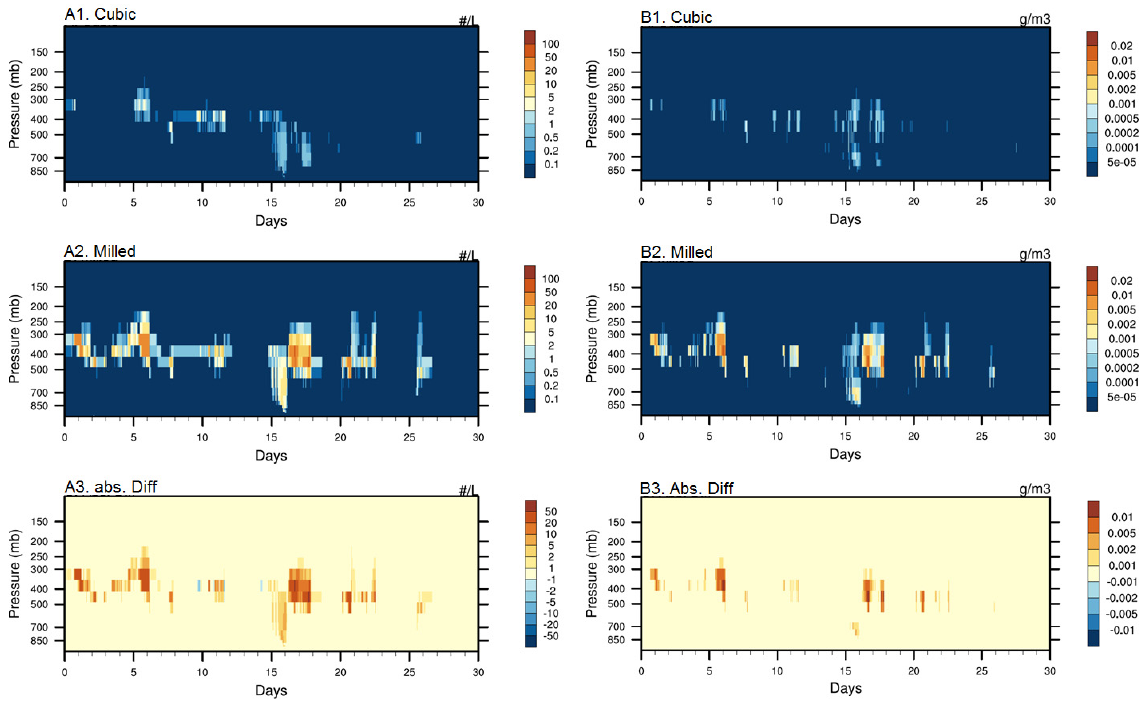
Fig. 4. Simulated time evolution of (A) ice crystal number concentration (color scaled; L − 1 ) and (B) mass mixing ratio of cloud ice (color scaled; gm − 3 ) over the ARM-SGP site in April 2010. Top panel shows the result of a simulation with cubic hematite particles and middle panel shows that of the milled hematite particles. Bottom panel shows the absolute difference between these two